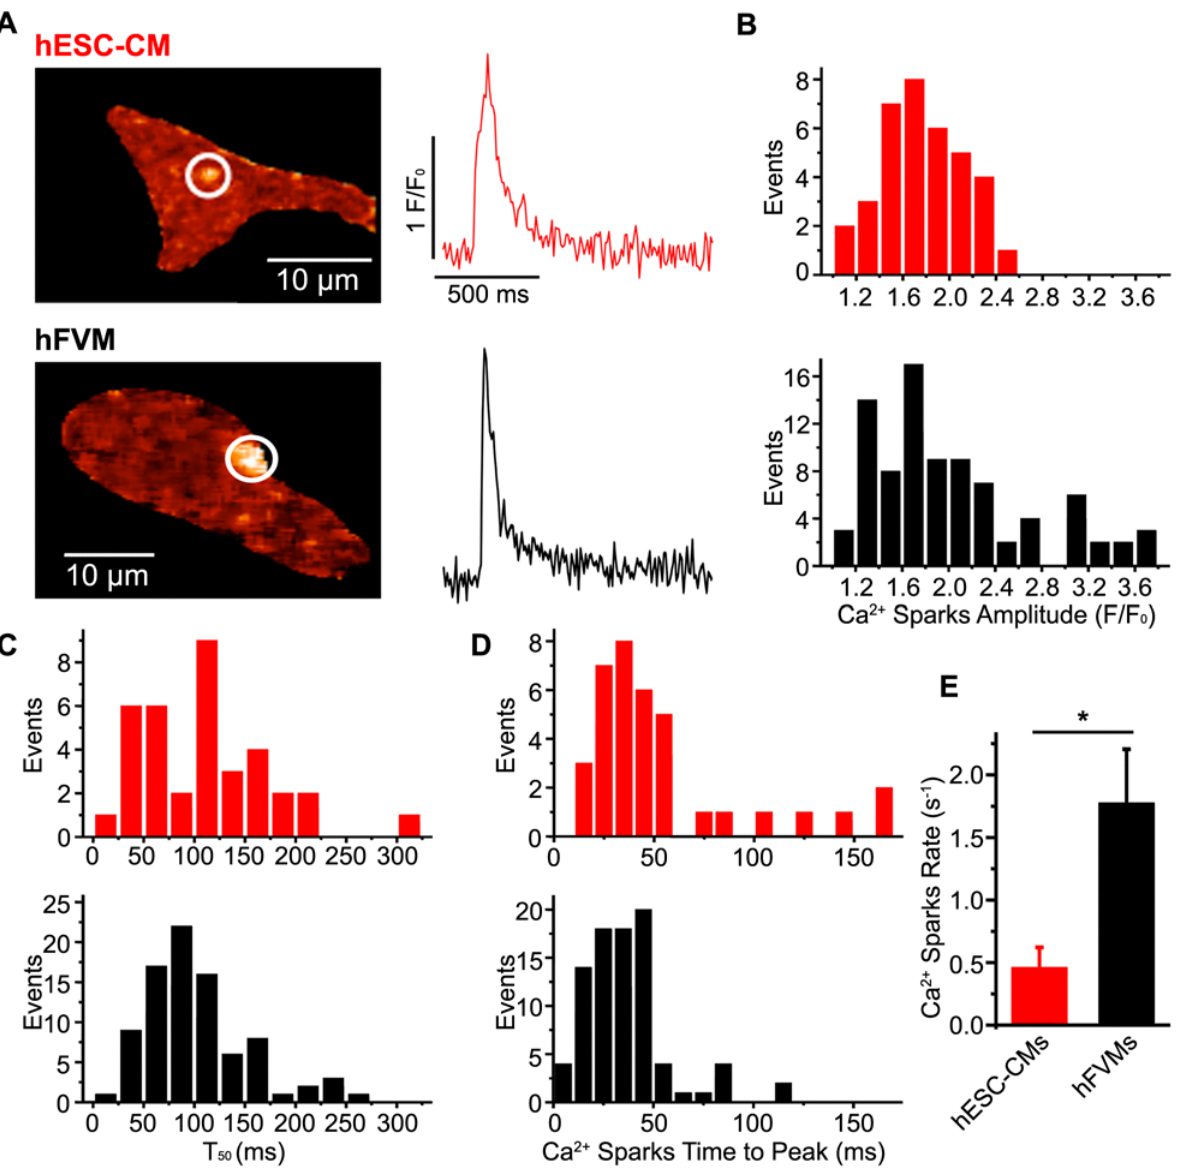
Figure 6. Ca 2 + sparks in hESC-CMs and hFVMs. A. Confocal images of Ca 2 + sparks in typical hESC-CMs and hFVMs. The traces to the right of each image show the time-course of [Ca 2 + ] i in each Ca 2 + spark site (red trace: hESC-CM, black trace: hFVM). Histograms of the amplitude (B), decay time to 50% amplitude (T 50 ) (C), and time-to-peak (D) for Ca 2 + sparks in hESC-CMs (red bars, upper) and hFVMs (black bars, lower). E. Bar graph indicating the rate of Ca 2 + spark occurrence in hESC-CMs and hFVMs. * p ,